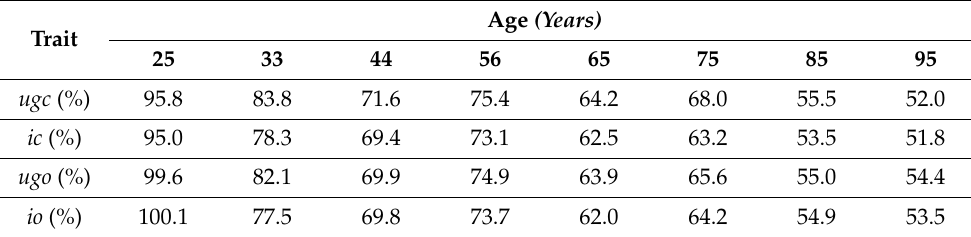
Table 5. Coefficients of variation for the size of the assimilatory